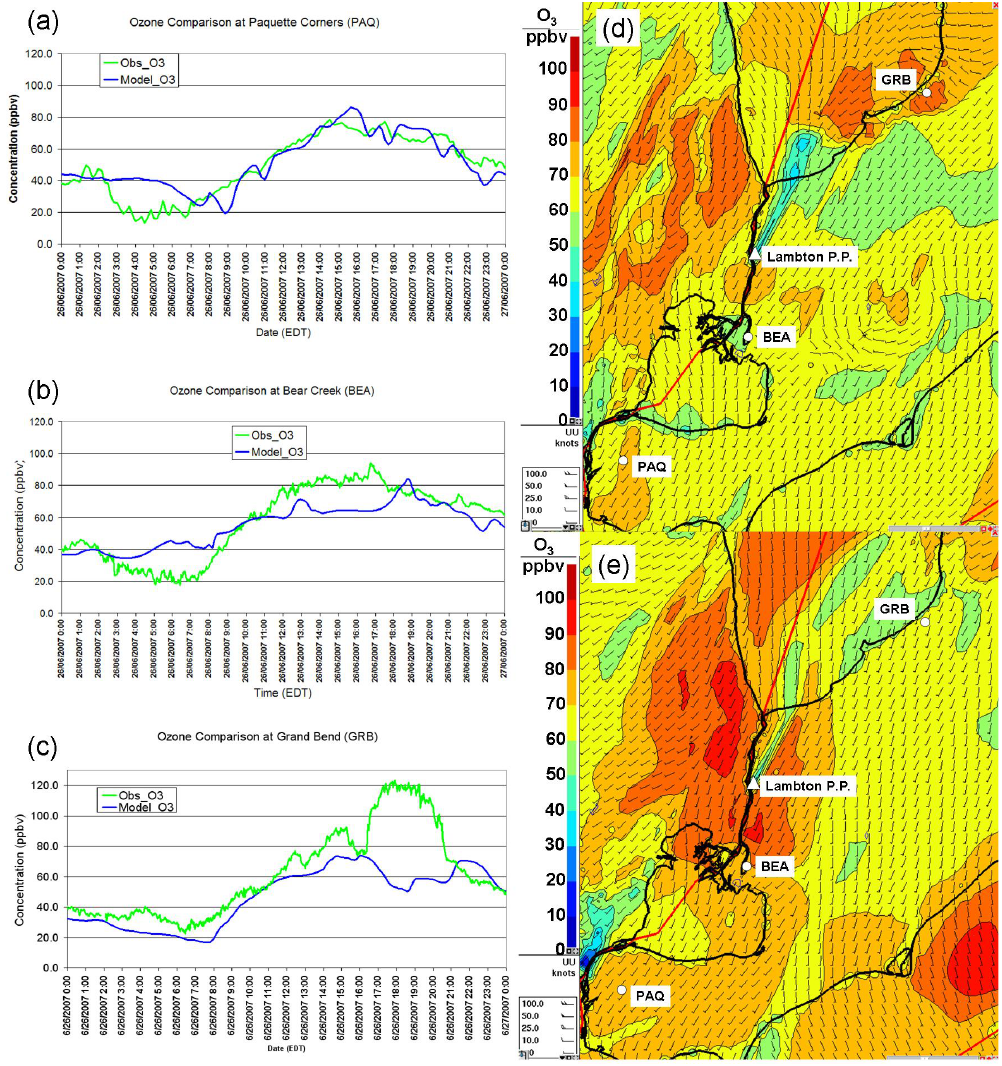
Fig. 10. Ozone comparison with surface observations, 26 June , at (a) Paquette Corners, (b) Bear Creek, (c) Grand Bend. Model surface ozone concentrations at (d) 18:00 UT (02:00p.m. local time) and (e) 23:00 UT (07:00p.m. local